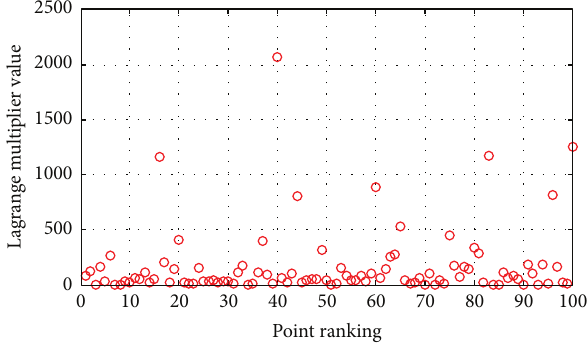
Figure 4: Lagrange multiplier